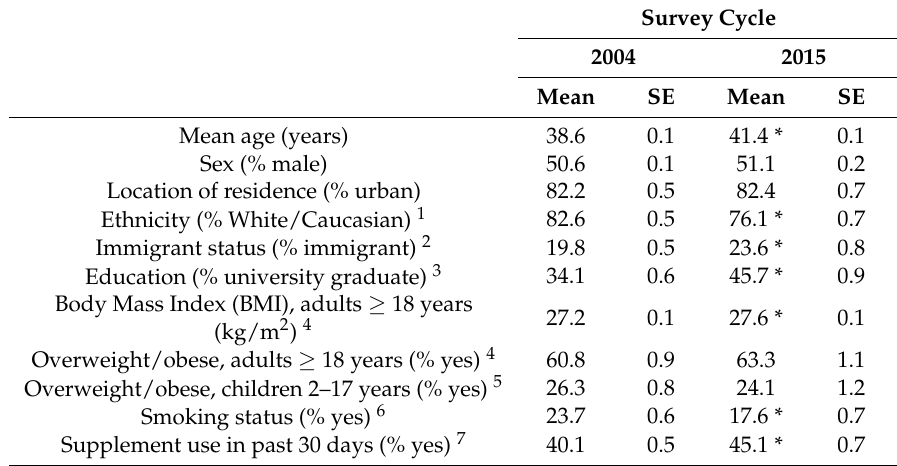
Table 3. Sociodemographic and lifestyle characteristics among Canadians aged 2 years and older in 2004 and in 2015 ( n = 33,514 in 2004 and n = 19,408 in 2015).